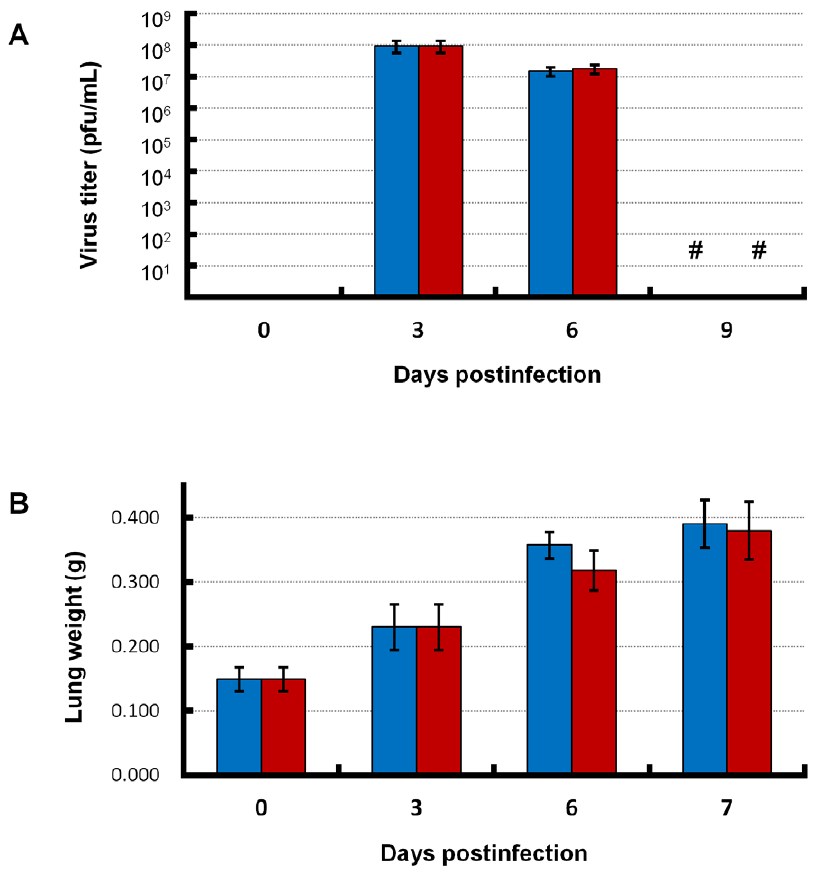
Figure 3. Virus titers in the lungs and lung weights of infected mice with combination therapy or monotherapy. (A) Virus titers in the lung homogenates of infected mice are shown. Mice infected with an extremely high dose (3741 MLD 50 ) of PR8 virus were treated with laninamivir octanoate. The mice were additionally administered artificial surfactant (combination therapy, red bars) or normal saline solution (monotherapy, blue bars) intranasally once daily during 3–14 days postinfection. Four mice in each group were sacrificed at the indicated days postinfection and their lung homogenates were used for a plaque-forming assay. Mean 6 SD viral titers are shown. The # symbol indicates under the detection limit. (B) Lung weights of four mice in the combination therapy (red bars) or monotherapy (blue bars) groups are shown. Mice were sacrificed at the indicated days postinfection and their lung weights were measured. Differences in means 6 SD are shown.